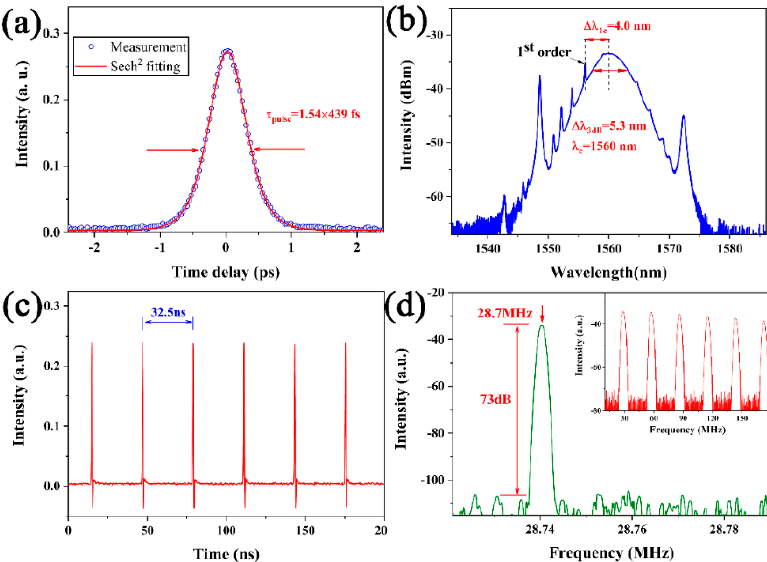
Figure 2. Output characteristics of CS using ML CNT-SA with a pump power of 40 mW in experiment. ( a ) The autocorrelation trace; ( b ) spectrum; ( c ) pulse trains; ( d ) RF spectrum, the inset shows the RF spectrum with a span of 180 MHz.